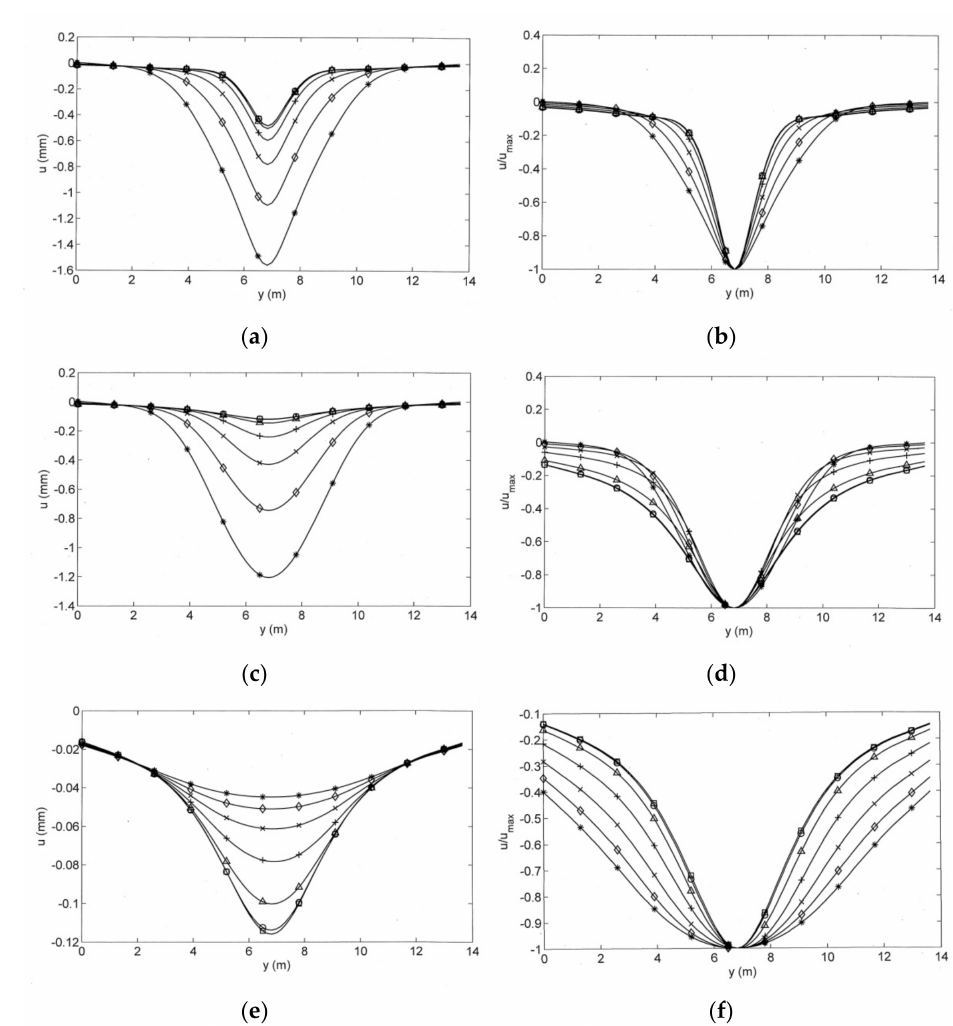
Figure 10. Calculated displacement distributions of the ( a , b ) rail, ( c , d ) track plate, and ( e , f ) base layer due to an axle load of F T = 100 kN. Slab track on a soil of v S = 200 m/s with increasing damage